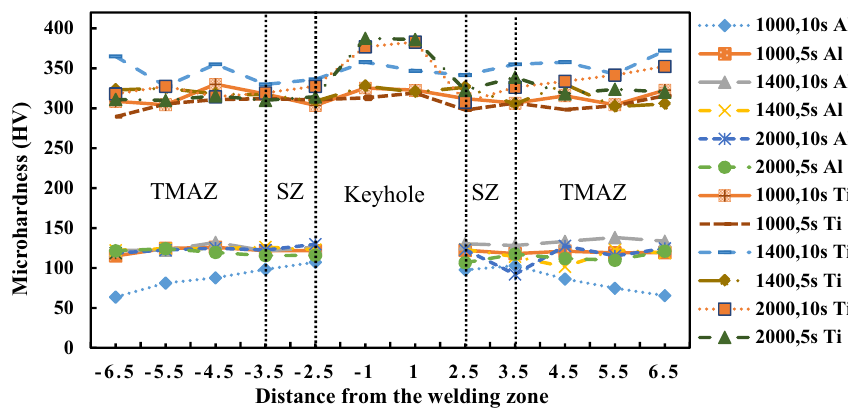
Figure 5: Micro - hardness values of weld interface at di ff erent rotational speeds and dwell